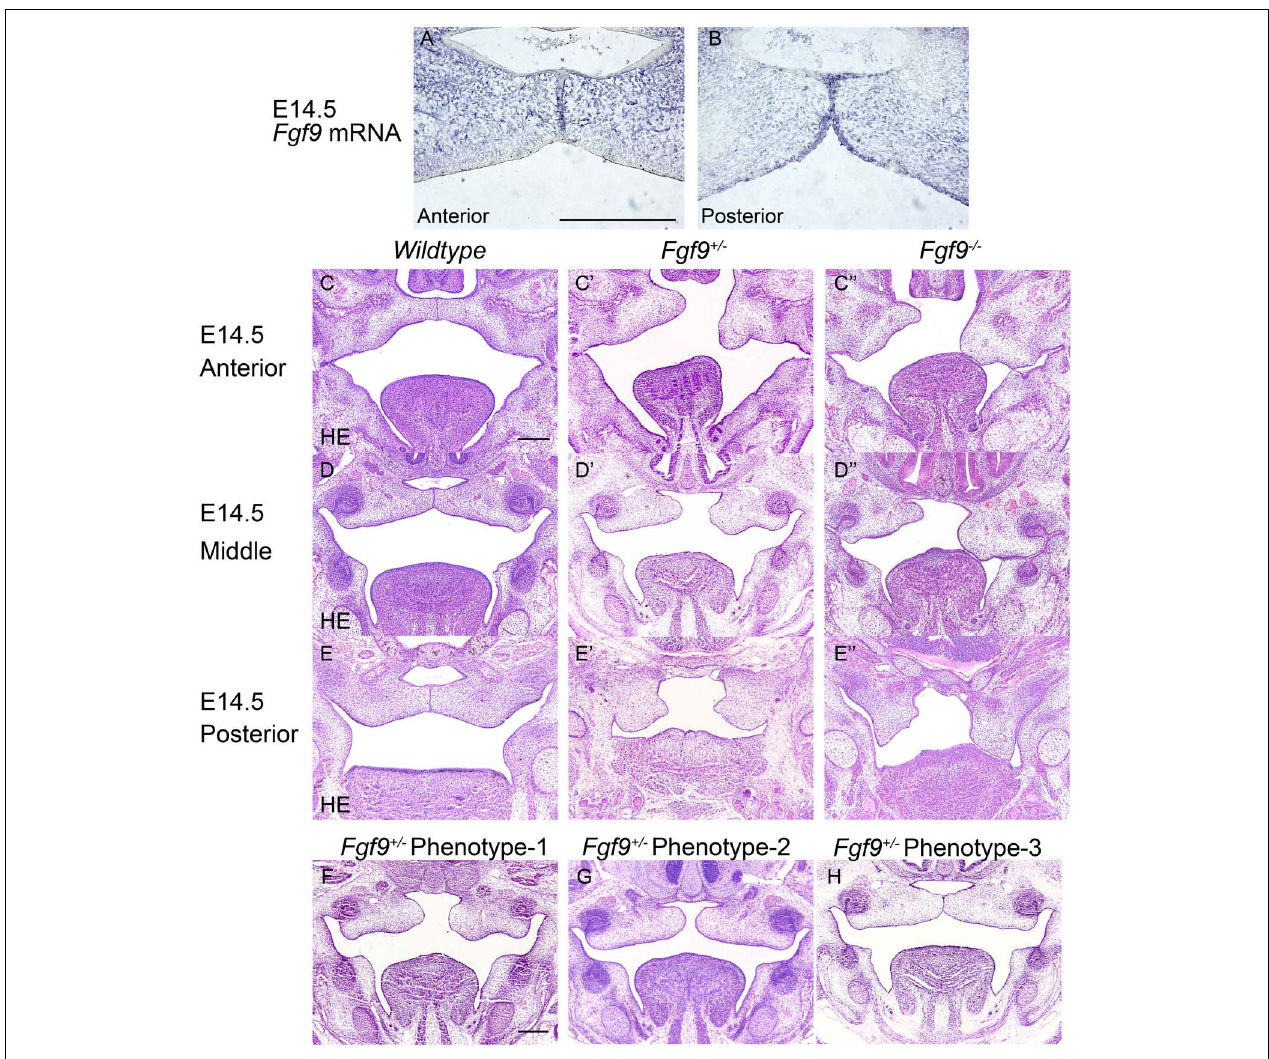
FIGURE 5 | Fgf9 expression and phenotypes of Wildtype , Fgf9 + / − , and Fgf9 − / − embryos at E14.5. Location of (A) Fgf9 mRNA and (B) FGF9 protein in anterior and posterior regions at E14.5. HE staining of of (C–C”) anterior, (D–D”) middle, and (E–E”) posterior palate in Wildtype , Fgf9 + / − , and Fgf9 − / − embryos at E14.5. (F–H) HE staining of various types of delayed palatal elevation in Fgf9 − / − embryos. Scale bars = 200 µ